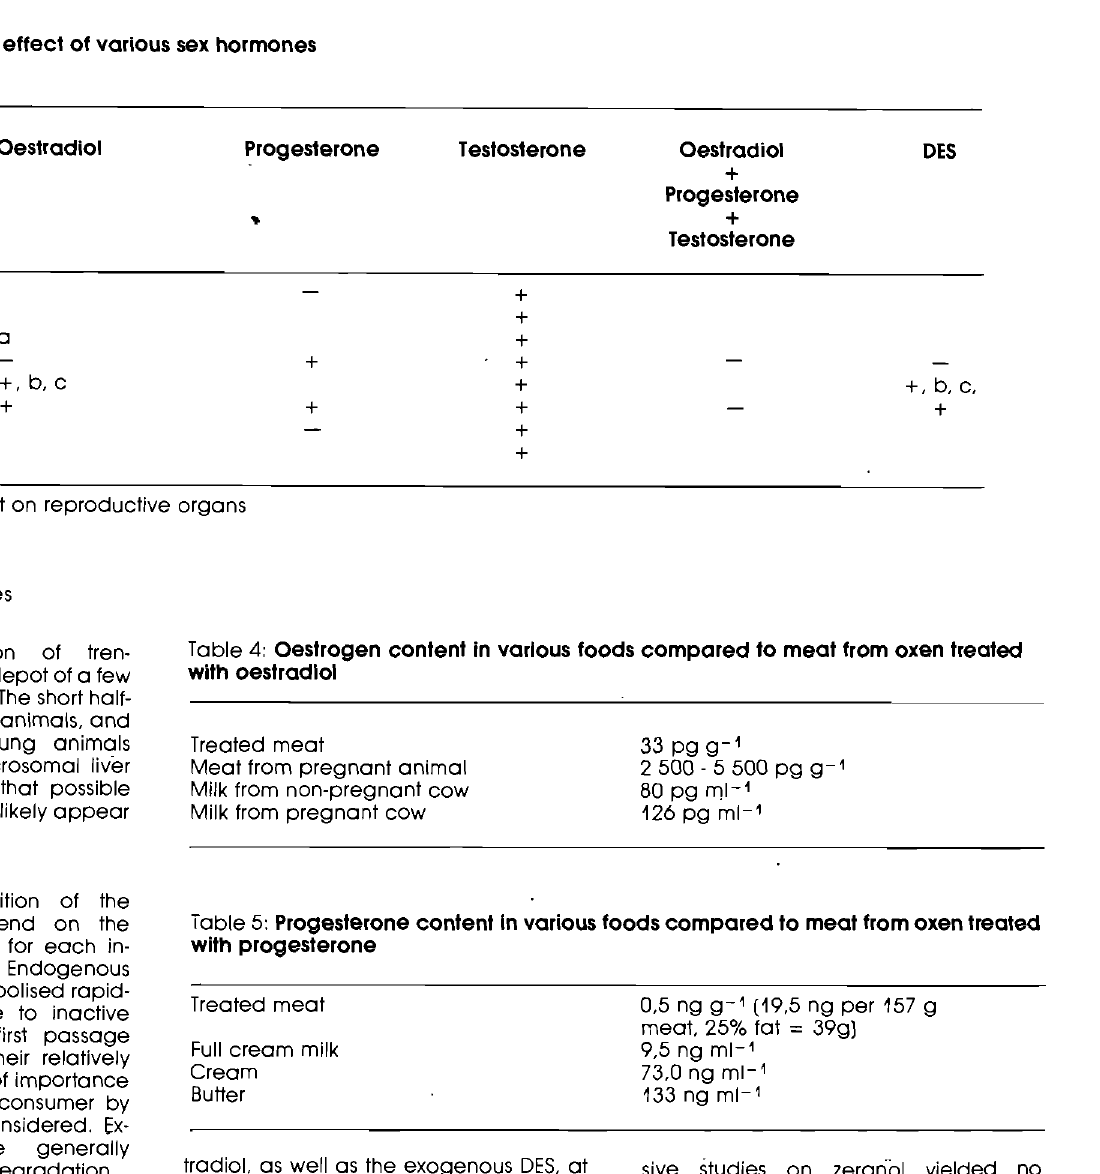
Table 5: Progesterone content In various foods compared to meat from oxen treated with progesterone Treated